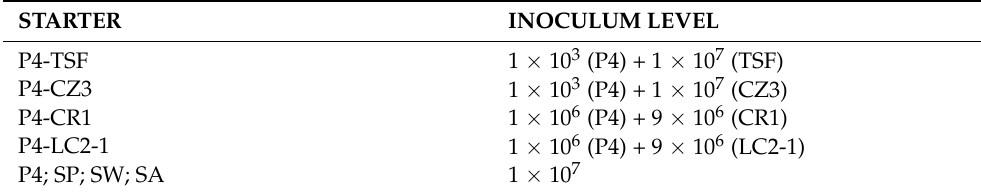
Table 1. Inoculum level of pure and mixed starters used in the different microfermentation